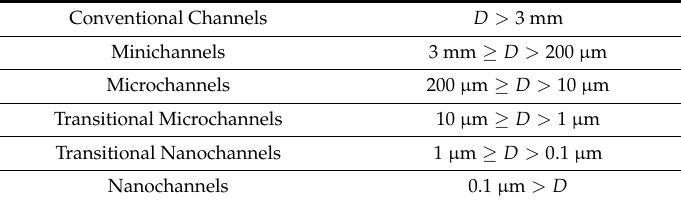
Table 1. Channel classification scheme